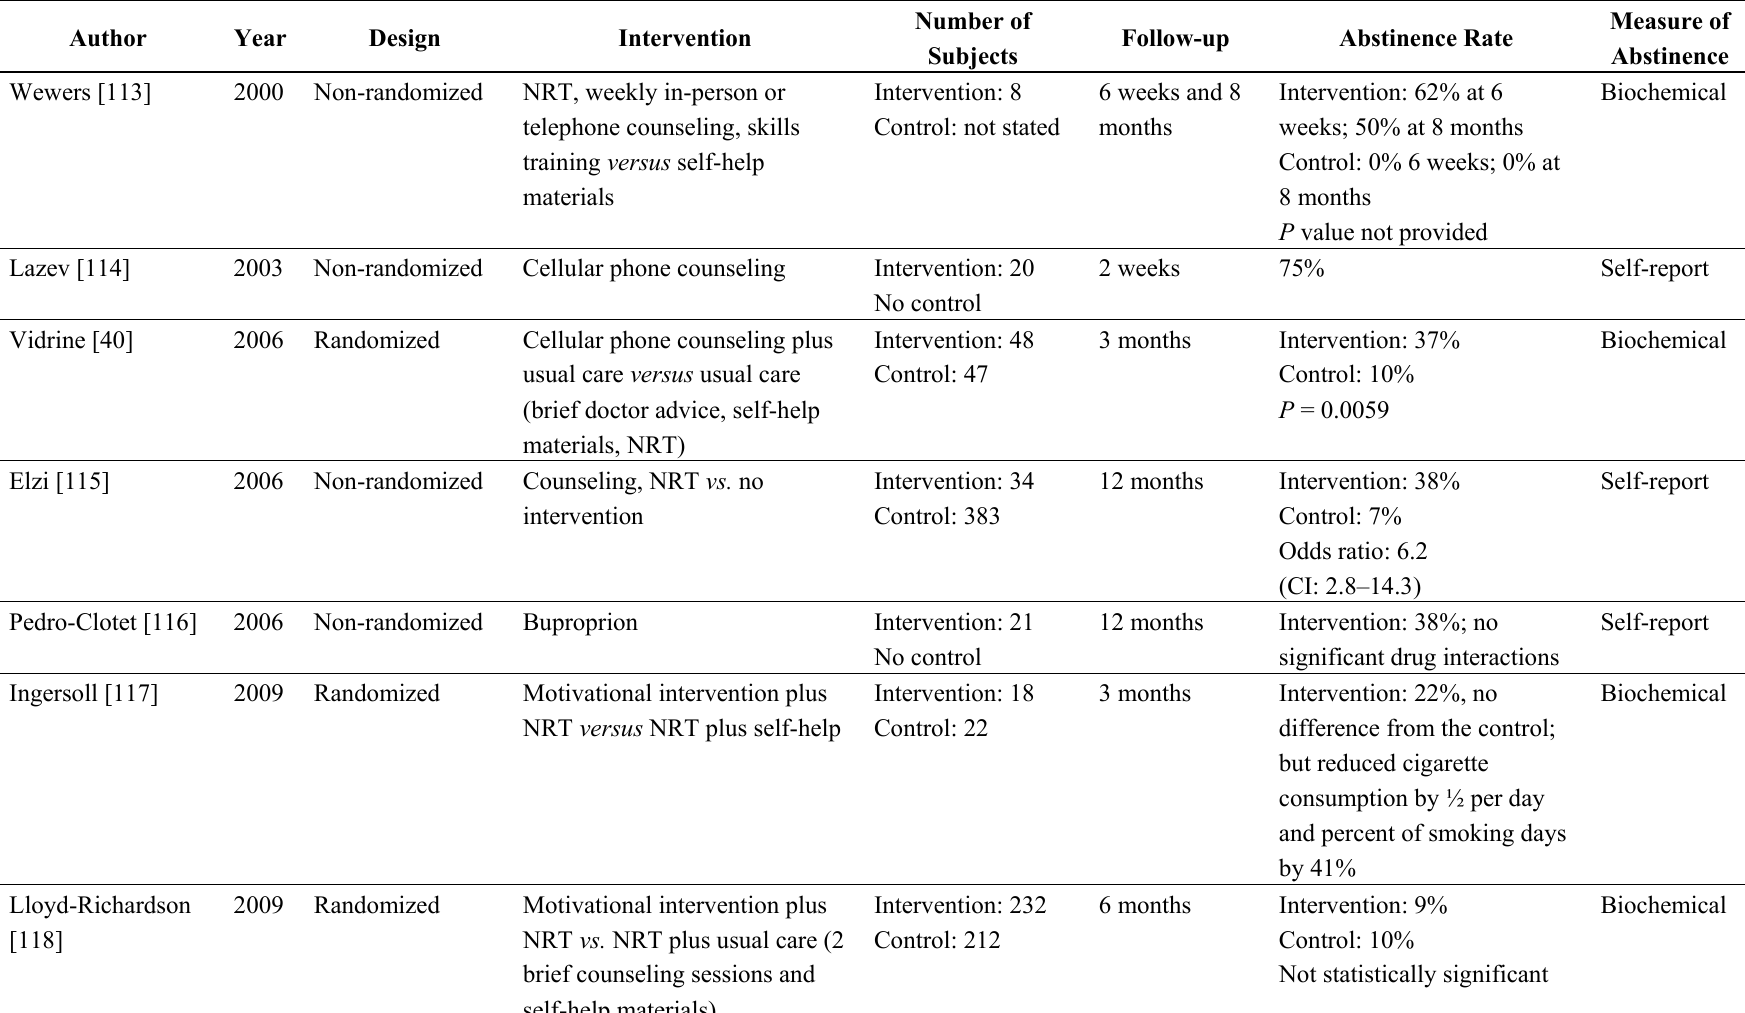
Table 3. Studies on tobacco cessation in the HIV-infected